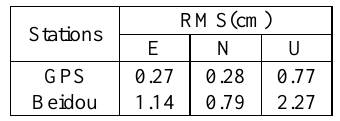
Table 3 .RMS of Time Series of Coordinates of